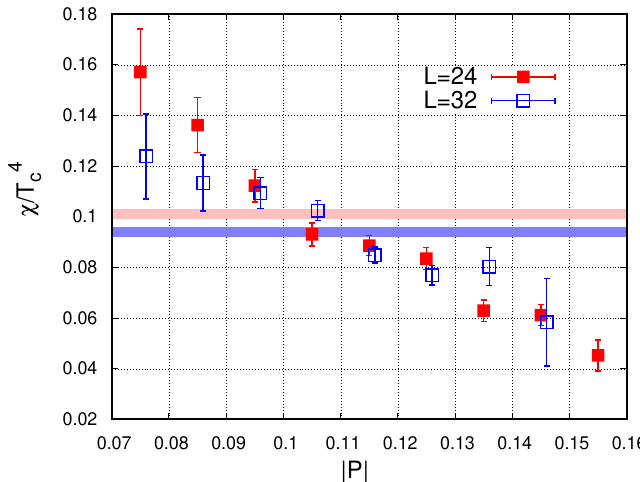
Figure 2. The dependence of the topological susceptibility on the value of the spatially averaged Polyakov loop in quenched lattice simulations. The susceptibility was computed by dividing the configurations in sets according to the spatially averaged Polyakov loop. The averages for the whole ensembles (in two volumes) are shown by the horizontal bands, the widths indicating the uncertainties. From Ref. [58]. (Figure adapted from R.Á. Vig and T.G. Kovács,